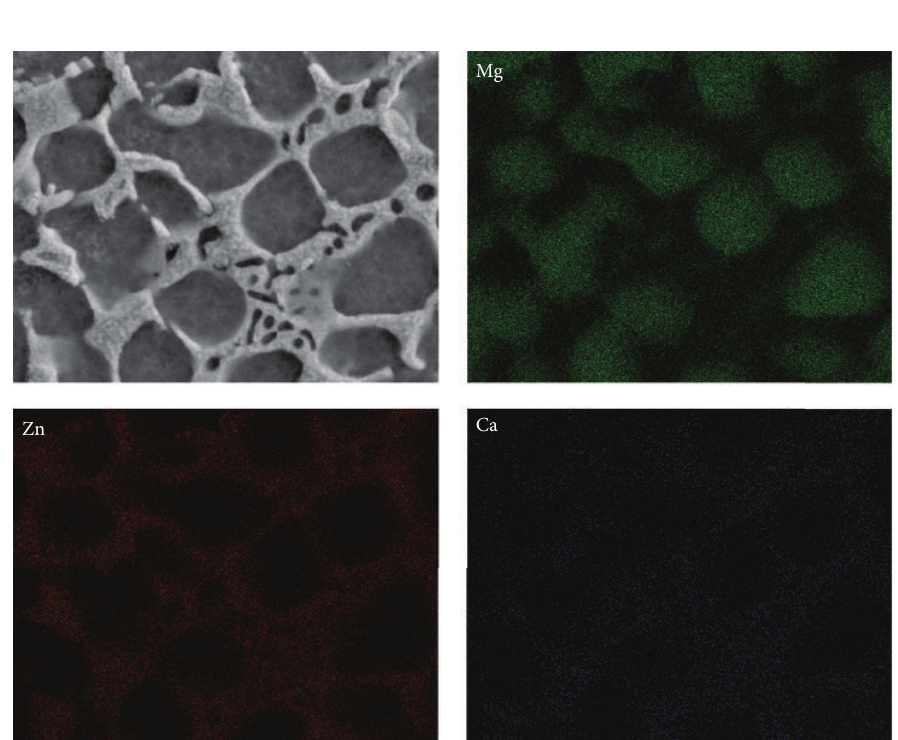
Figure 4: Analysis of elemental composition on the surface by EDX mapping of Mg-35Zn-3Ca alloy.